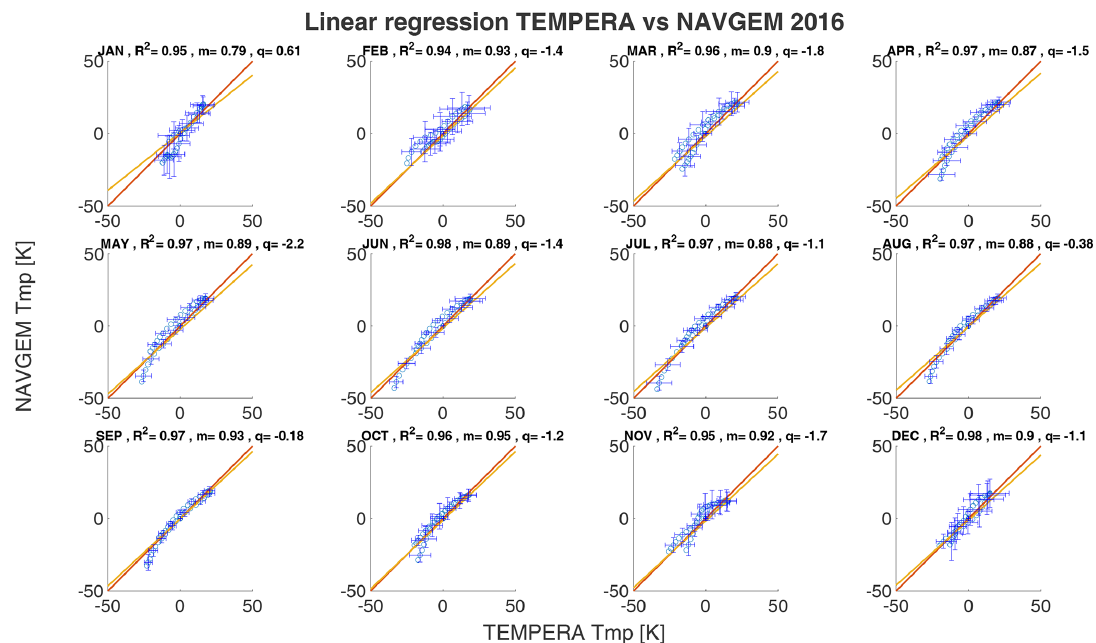
Figure 7. Linear regression of TEMPERA against NAVGEM-HA temperatures.